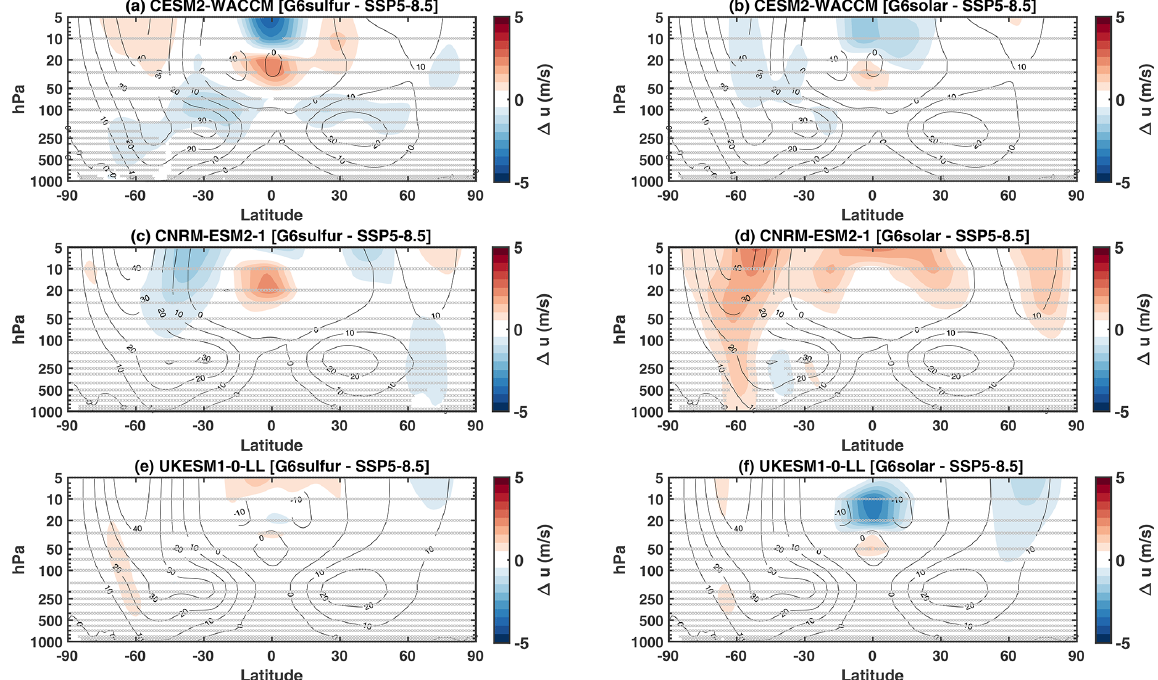
Figure A3. Zonal mean U winds changes (ms − 1 ; 2030–2039) between G6sulfur and SSP5-8.5 (a, c, e) and G6solar and SSP5-8.5 (b, d, f) for the three GeoMIP models with interactive chemistry that participated in the G6 experiment. Contour lines show the baseline SSP5-8.5 winds. Gray horizontal lines indicate changes that are not statistically significant over the time period considered when using a double-sided t test at 95% confidence